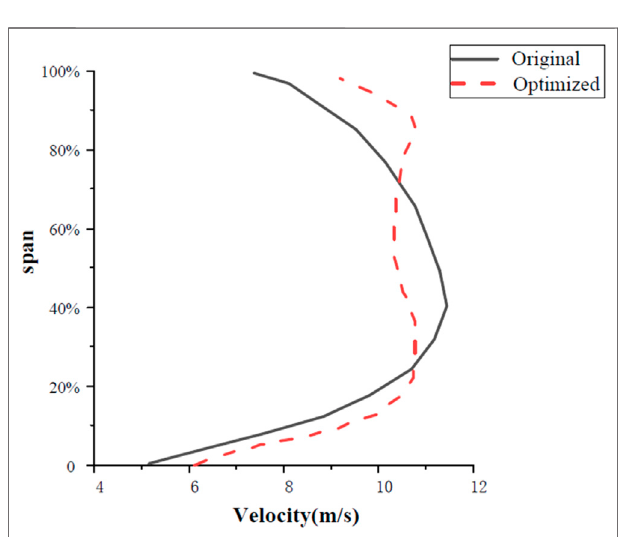
FIGURE17| Originalandoptimizedaveragevelocityisolinedistributions at different blade heights.